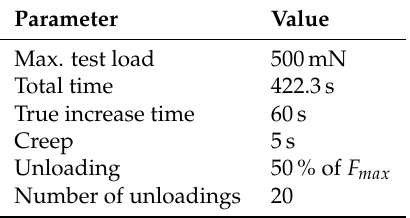
Table 4. Parameters used for the ESP